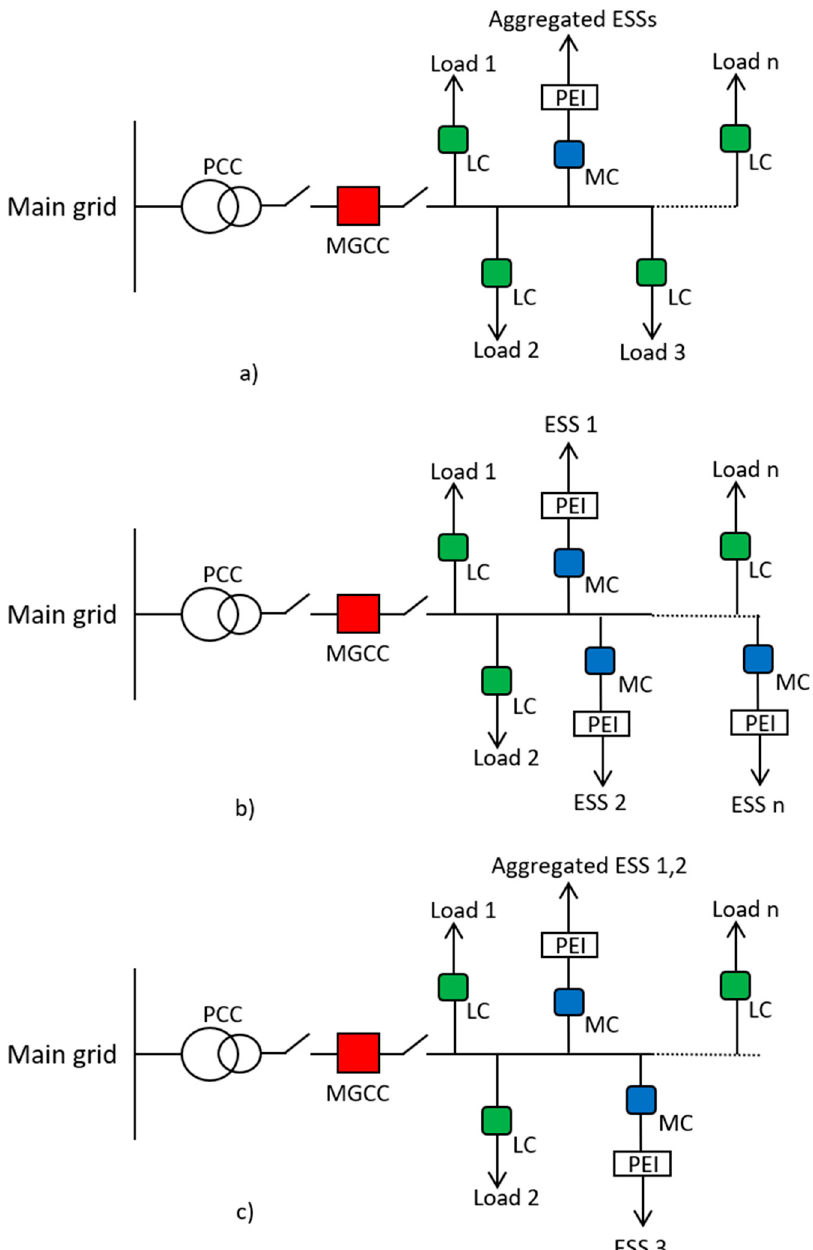
Figure 5. ESSs configuration in MGs. ( a ) aggregated, ( b ) distributed, and ( c ) hybrid ESSs.